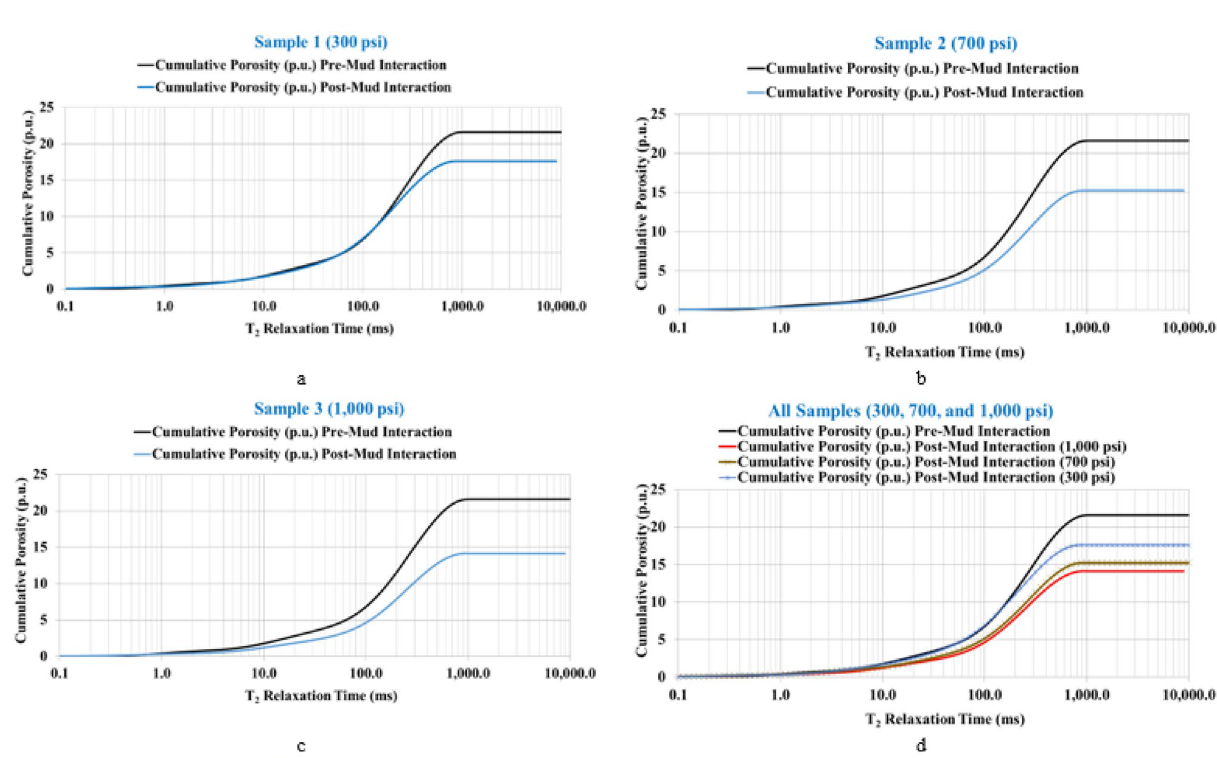
Figure 5. The cumulative porosity plots with the overbalance pressure. ( a ) Under 300 psi overbalance. ( b ) Under 700 psi overbalance. ( c ) Under 1000 psi overbalance. ( d ) all